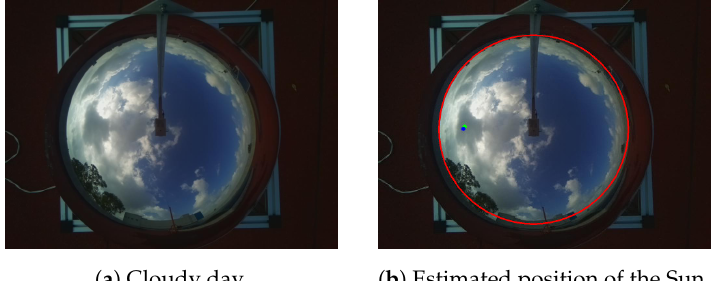
Figure 11. Estimation of the Sun’s position when it is occluded by a cloud. ( a ) shows the input image where the Sun is occluded by some clouds, while in ( b ), the position estimation made by the Pysolar library (blue dot), as well as the position computed by the particle filter (green dot) are